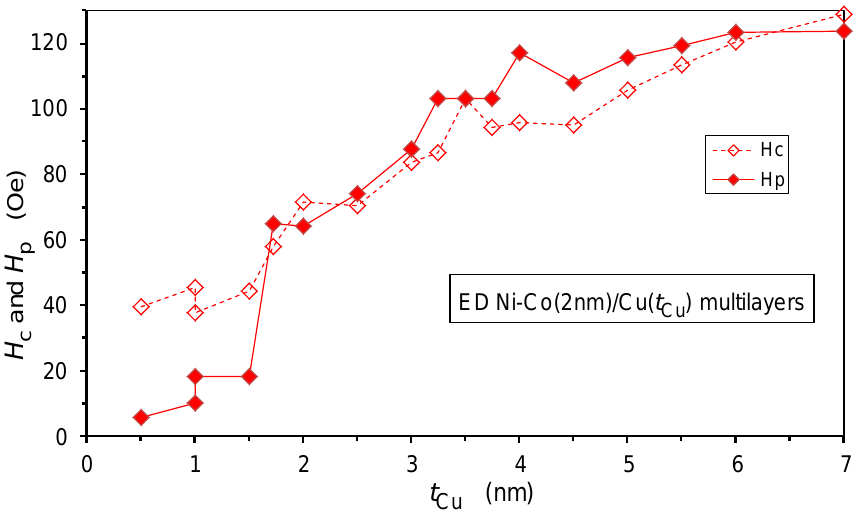
Figure 16. Evolution of the coercive field H c and MR ( H ) peak position H p with spacer layer thickness t Cu for the present Ni 65 Co 35 /Cu multilayers.